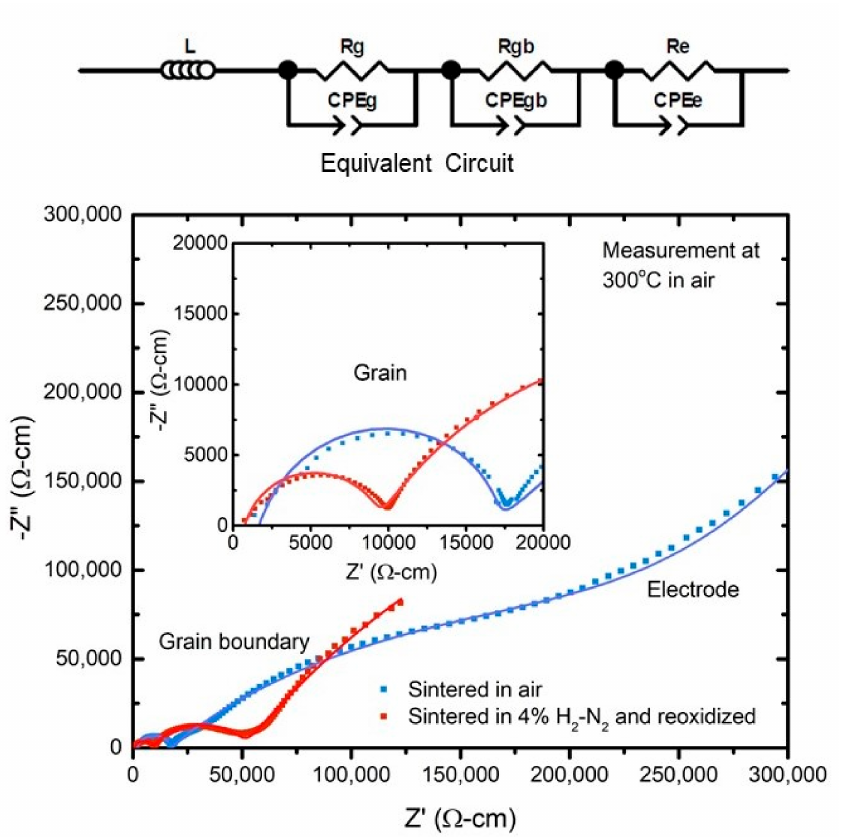
Figure 3. Normalized Nyquist plot showing the comparison between the 10GDC control and H 2 sintered samples measure at 300 ◦ C in air, along with its equivalent circuit. The equivalent circuit is comprised of three pairs of parallel R-CPE elements in series with each other, R being the resistive component and CPE being a constant phase element representing the capacitive component. Here ‘g’ stands for grain, ‘gb’ stands for grain boundary, and ‘e’ stands for electrode and each R-CPE pair corresponds to each of the three arcs. There is an additional inductive element L for the measurement setup. The scatter plot is the measured data, and the line is the